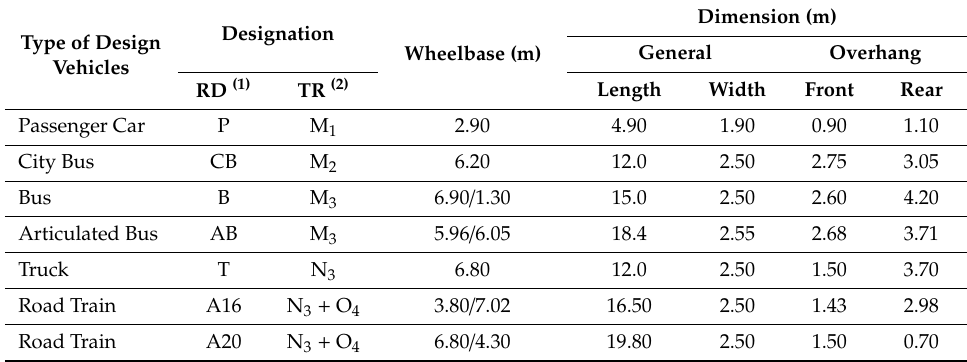
Figure 11. Template for the design of curves in the plan with the minimum radius of the design vehicle: ( a ) passenger car (P); ( b ) city bus (CB); ( c ) bus (B); ( d ) truck (T); ( e ) articulated bus (AB); ( f ) road train (A16) [42]. Table 1. Recommended size of design vehicles (see Figure 11).